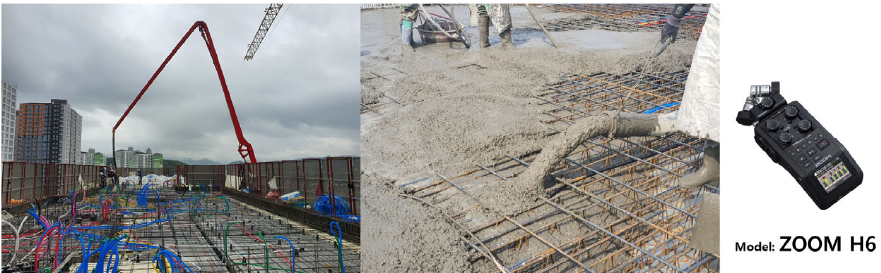
Figure 2. Construction site sound data collection.